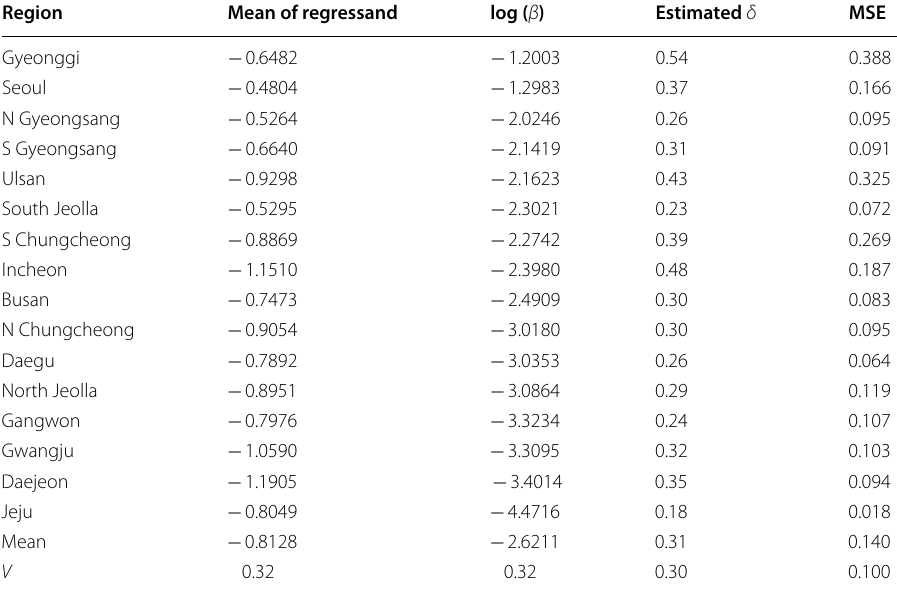
MSE mean square error, V coefficient of variation